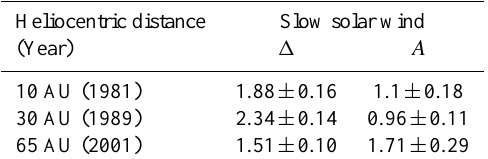
Table 1. Degree of multifractality 1 and asymmetry A for solar wind data in the outer heliosphere during solar